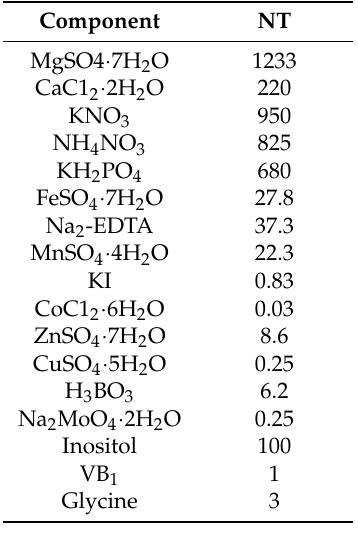
Table A3. NT culture medium component